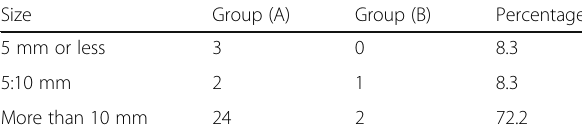
Table 4 The number of masses according to their size